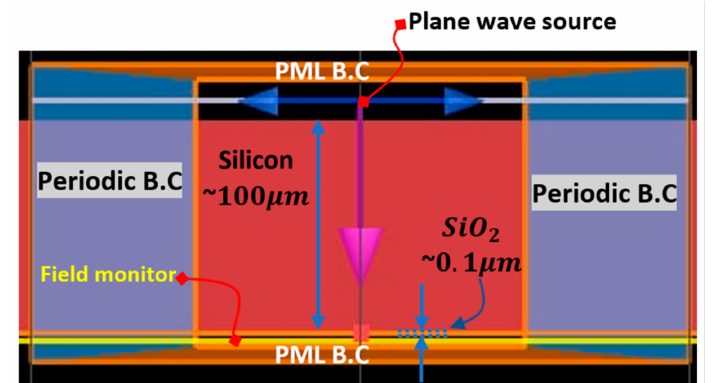
Figure 4. The simulation model and setup. The simulated area is outlined by the orange rectangle. The lateral dimensions are in the order of 0.1 µ m. PML B.C.: perfectly matched layer boundary conditions. As can be seen in Figure 4, on the sides of the FDTD region periodic boundary conditions were applied and on the top and bottom of the FDTD region a perfectly matched layer (PML) boundary conditions were applied. A radiation source with the wavelength range of 5–20 µ m was set above the TMOS cap. The refractive indices of the materials were set by the software using Palik data